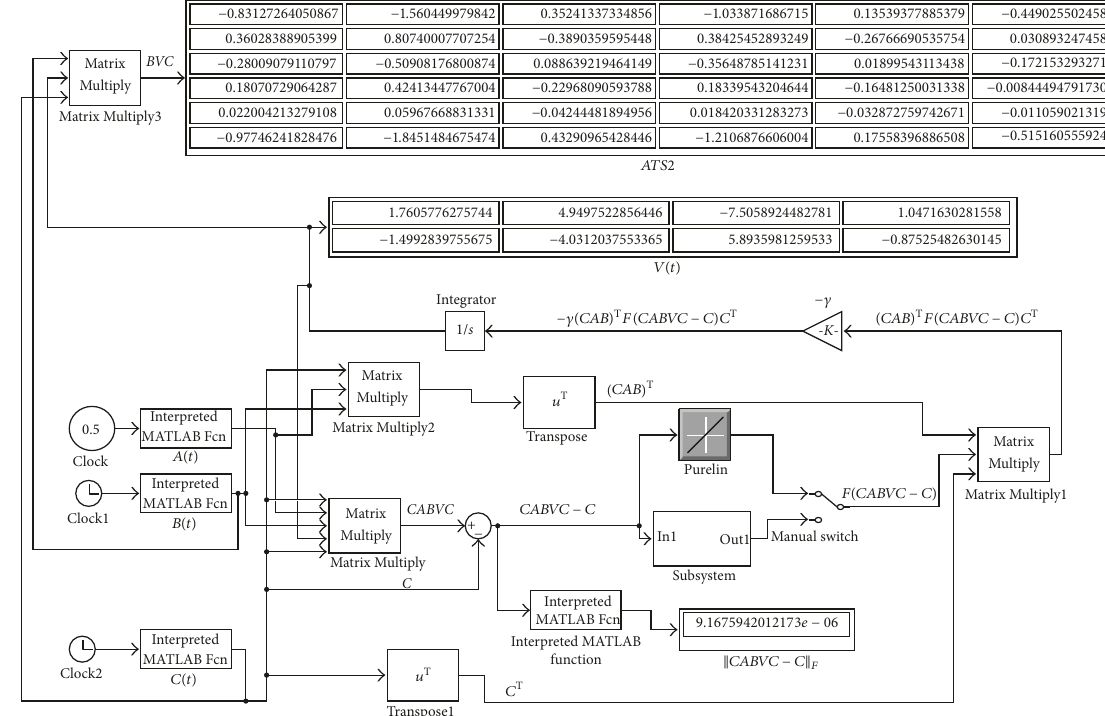
Figure 4: Simulink implementation of the GNN model for computing 𝐶𝐴𝐵𝑉(𝑡)𝐶 = 𝐶 , 𝑋 1 = 𝐵𝑉𝐶